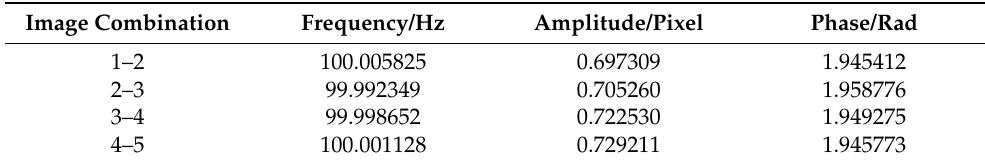
Table 2. Statistical results of relative jitter error curve fitting by single disparity map generated from two adjacent sequence images. Figure 5. The 100 − Hz Jitter detection curves and Fourier analysis results by single disparity map generated from two adjacent sequence images. ( a ) Jitter detection curve by image 1–2; ( b ) Fourier analysis results of jitter detection curve by image 1–2; ( c ) Jitter detection curve by image 2–3; ( d ) Fourier analysis results of jitter detection curve by image 2–3; ( e ) Jitter detection curve by image 3– 4; ( f ) Fourier analysis results of jitter detection curve by image 3–4; ( g ) Jitter detection curve by image 4–5; ( h ) Fourier analysis results of jitter detection curve by image 4–5.